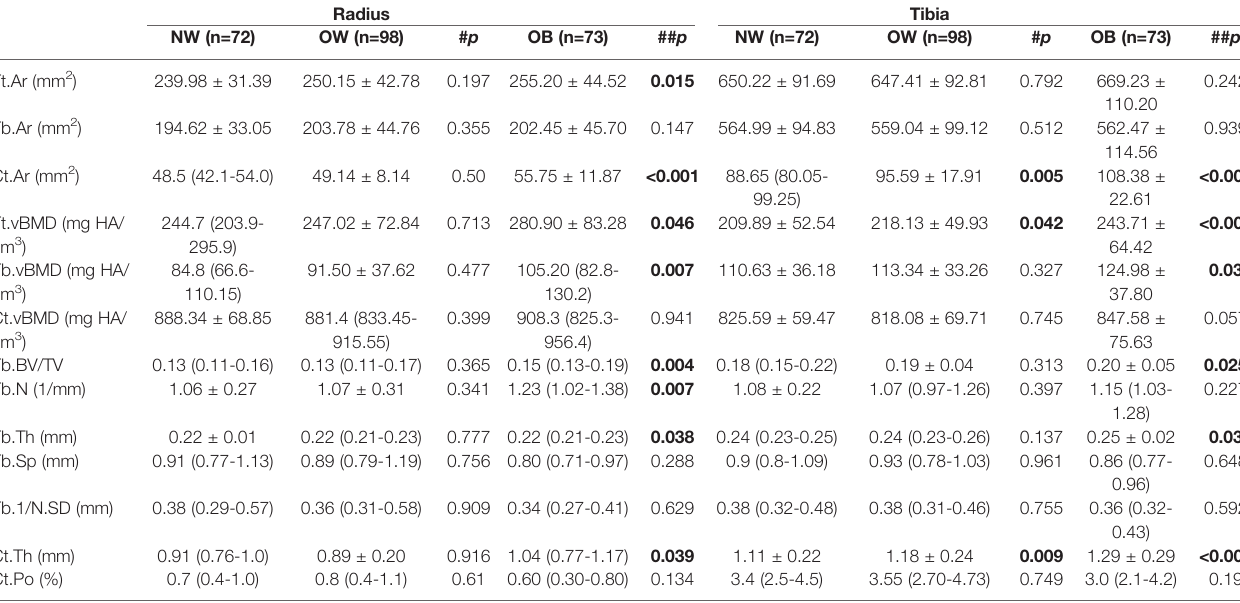
TABLE 3 | Adjusted comparisons of microarchitecture characteristics in normal-weight (NW), overweight (OW), and obese (OB) postmenopausal women at the radius and tibia. Radius NW (n=72)